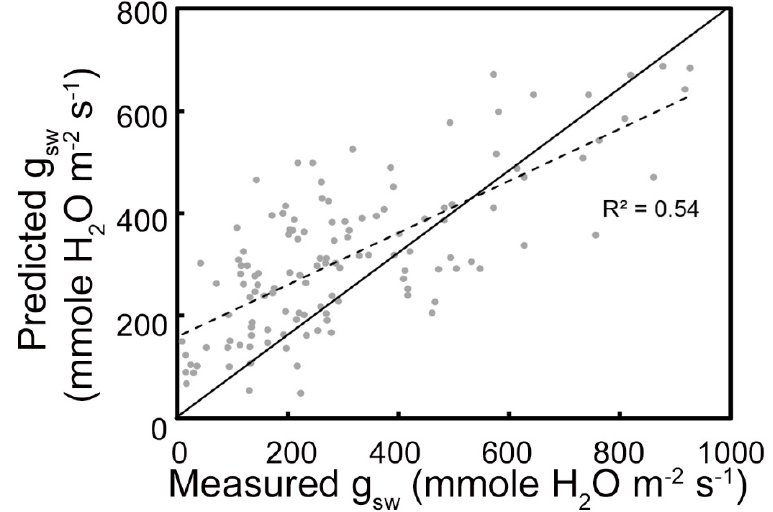
Figure 7. Results of stomatal conductance calculation by the ANN model compared to the actual acquired data.